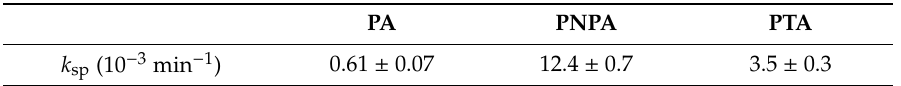
Table 2. The pseudo first-order rate constants of spontaneous hydrolysis of PA, PNPA and PTA